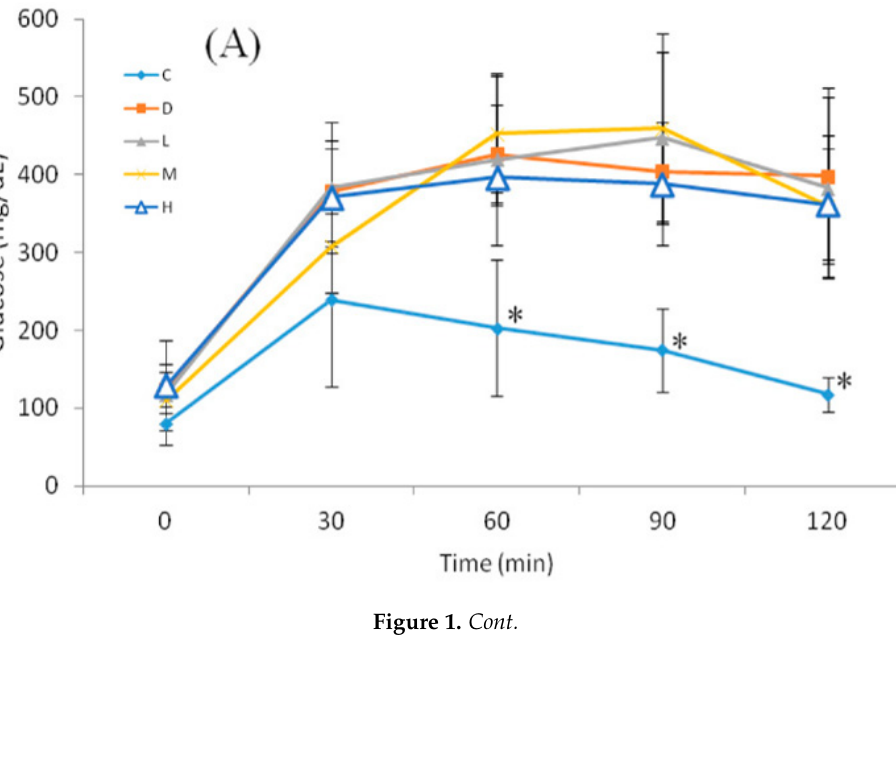
Figure 1. Oral glucose tolerance test (OGTT): ( A ) before; and ( B ) after the six ‐ week melatonin intervention. All values are the mean ± SD ( n = 8). * p < 0.05 compared to the diabetic group. # p < 0.05 compared to the diabetic group. Abbreviations: control group (C), diabetic group (D), low ‐ dosage group (10 mg melatonin/kg of body weight (BW), L), medium ‐ dosage group (20 mg melatonin/kg of BW, M), and high ‐ dosage group (50 mg melatonin/kg of BW, H). Table 4. Glucose tolerance before and after the six ‐ week melatonin intervention. Title